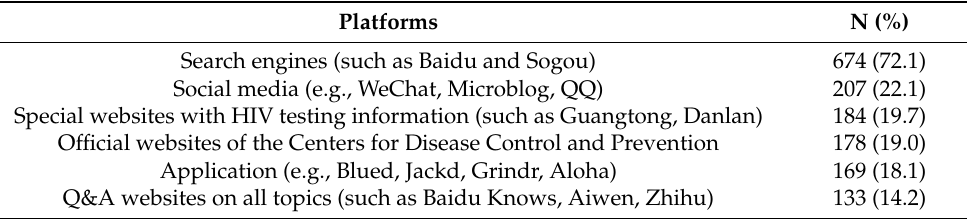
Table 3. The platforms used to search for information about HIV